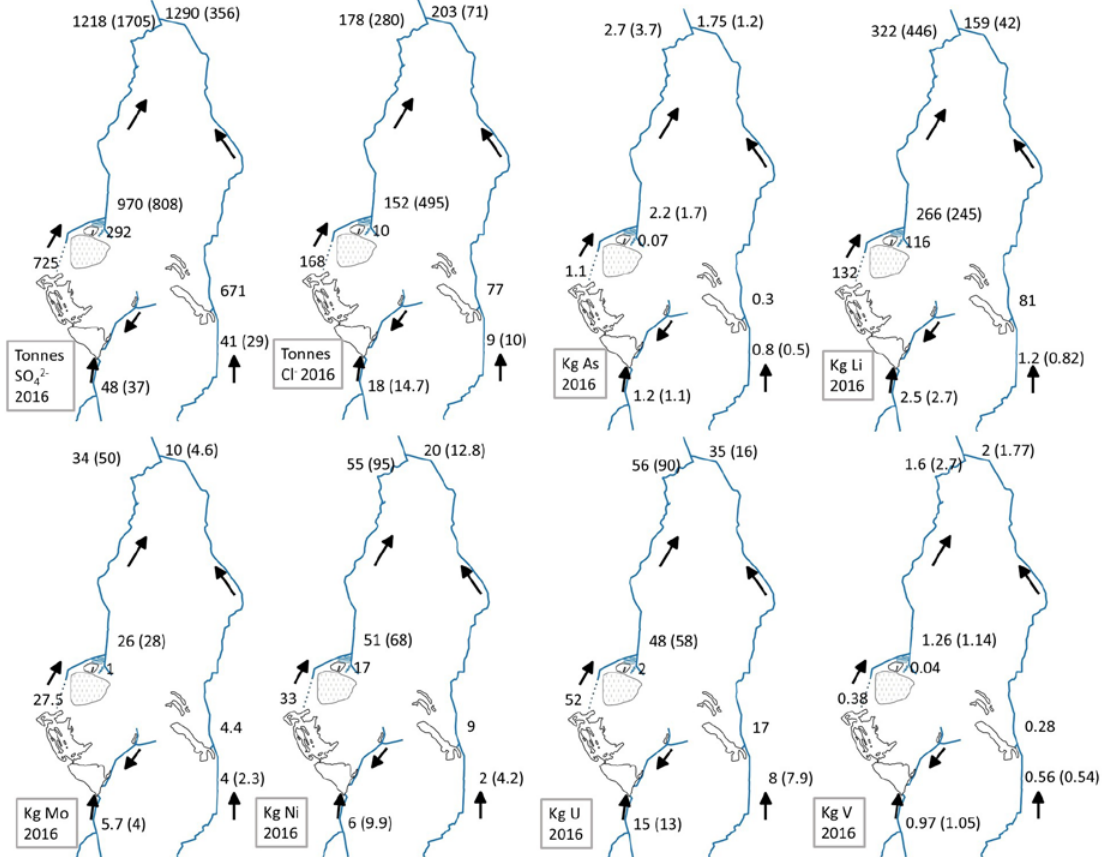
Figure 7. Estimated mass transport of SO 42 − , Cl − , As, Li, Mo, Ni, U and V in 2016 calculated with method 2 (results from method 1 in parentheses).